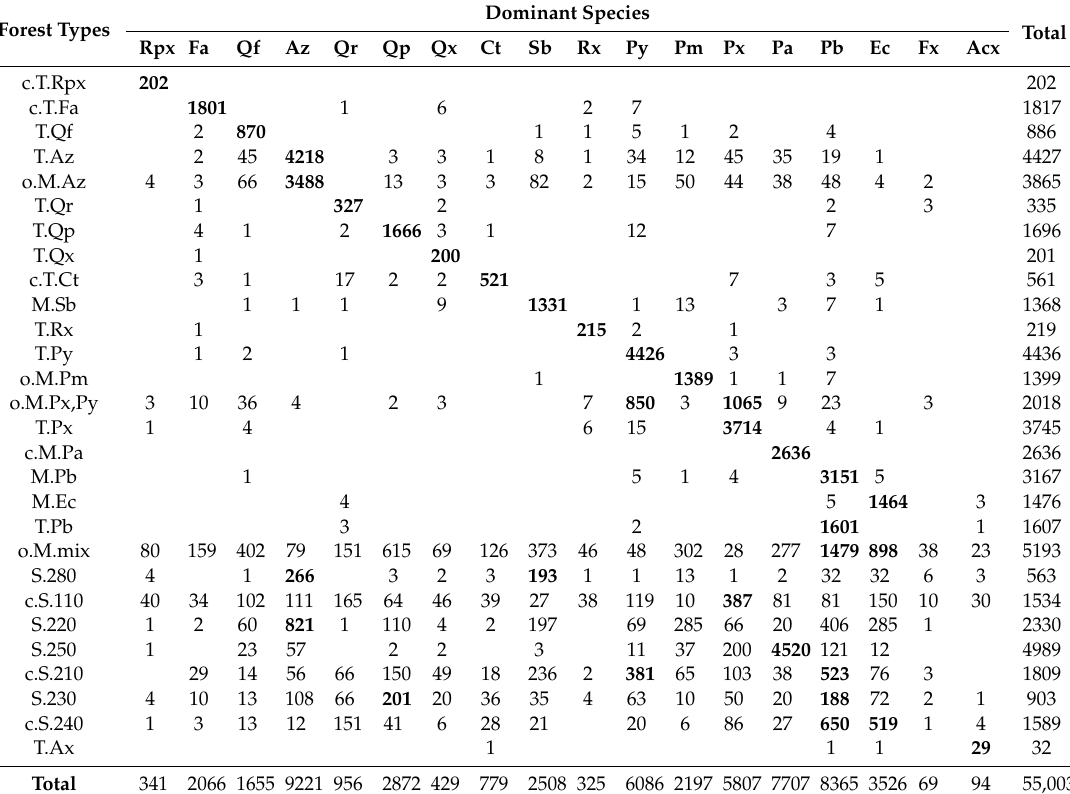
Table 3. Comparison of forest types and National Forest Inventories (NFI) classification for Portugal and Spain based on dominant species for all plots. Highlighted values indicate higher number of plots belonging to a forest type for each dominant species. The forest types are organized in three groups: (i) first related with oaks and other broadleaves, (ii) second with pines and eucalypts, (iii) third dominated by